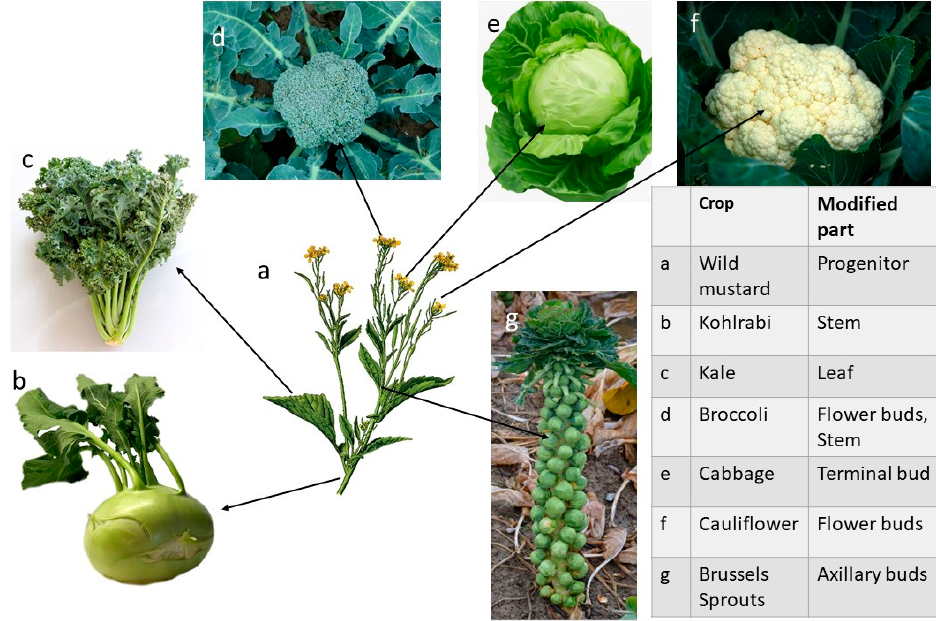
Figure 3. A whole range of Brassica vegetables have been selected during the diversification of Brassica oleracea (mustard), first domesticated as an oil-yielding crop in the Kurdistan/Mesopotamia area. Brussels sprouts are the youngest in the family of these vegetables, selected in Belgium in the mid-18th century.